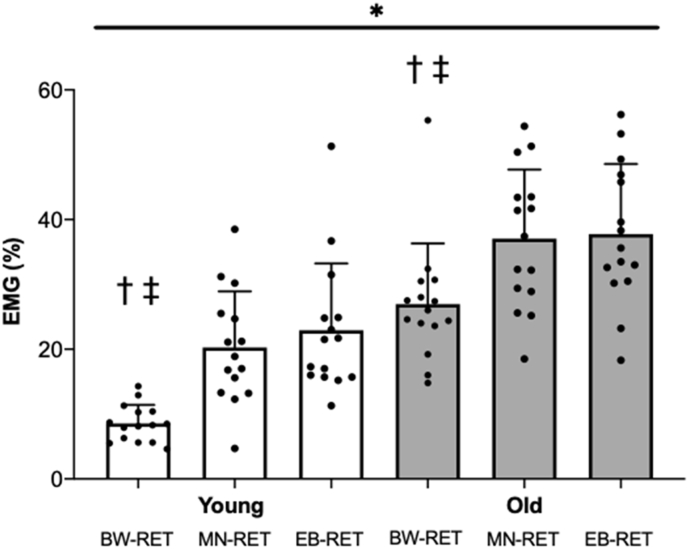
Quadriceps muscle EMG activity during bodyweight, elastic and machine resistance exercise.EMG activity of the quadriceps during, bodyweight (BW-RET), elastic band (EB-RET) and machine (MN-RET) resistance exercise training modalities in young (white bars) and old (grey bars) adults, with values presented as means ± standard deviation. * Indicates significant (P < 0.001) differences in muscle activity between groups; † significantly lower than MN-RET (P < 0.001); ‡ significantly lower than EB-RET (P < 0.001).